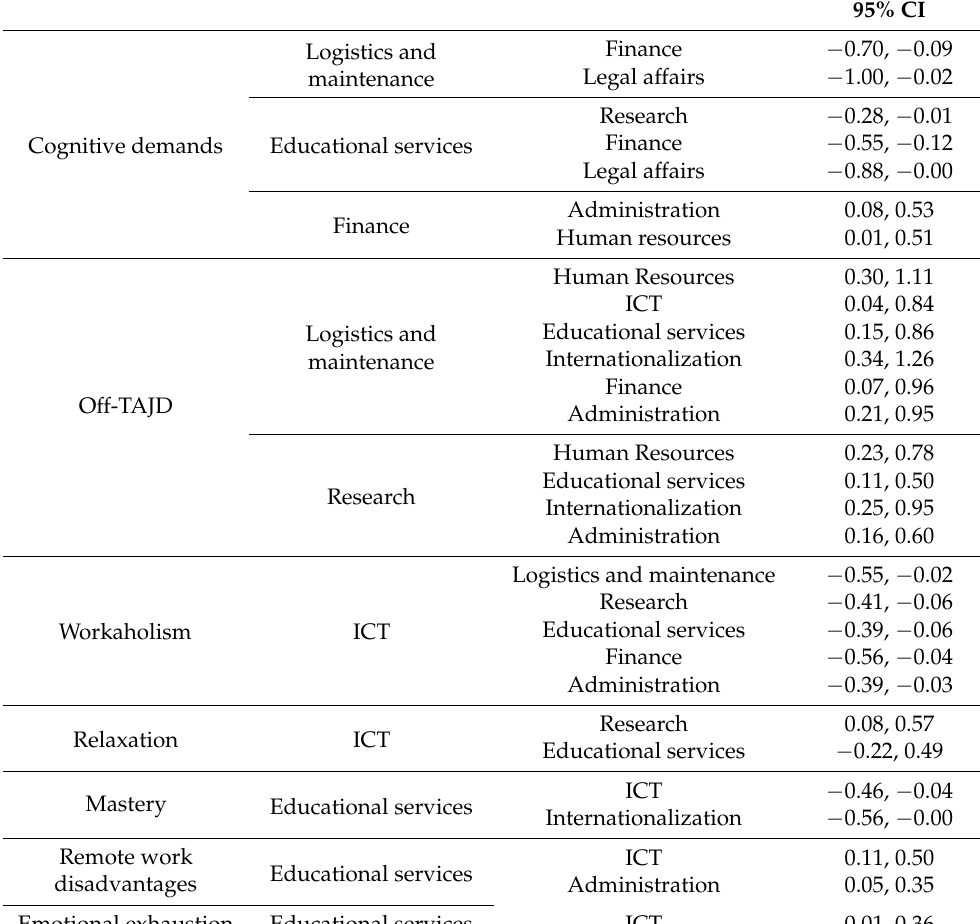
Table 3. ANOVA post hoc tests for the TAS sample by work